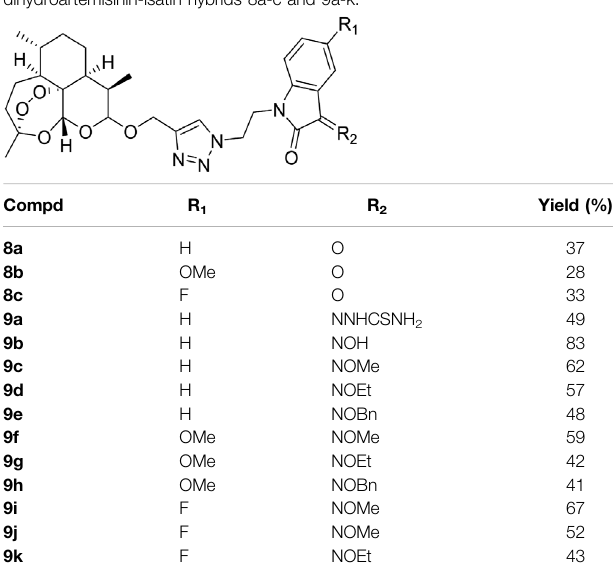
TABLE 1 | Chemical structures and yields of 1,2,3-triazole tethered dihydroartemisinin-isatin hybrids 8a-c and 9a-k.